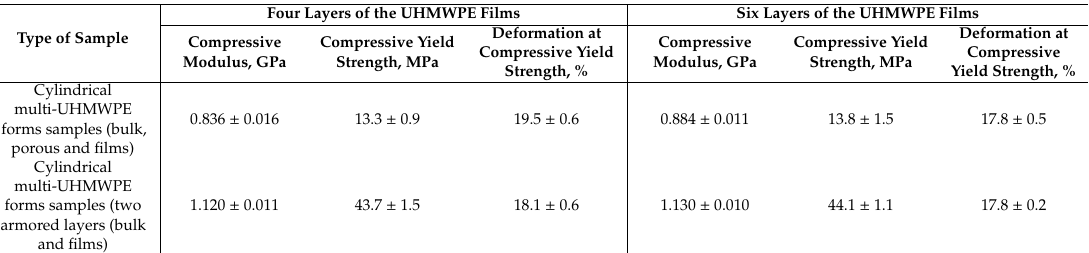
Table 5. Mechanical test results for the cylindrical multi- UHMWPE forms samples glued by thiol-ene glue with four and six layers of the UHMWPE films according to ASTM D-695. Four Layers of the UHMWPE Films Six Layers of the UHMWPE Films Deformation at Deformation at Compressive Compressive Yield Compressive Compressive Yield Compressive Yield Compressive Modulus, GPa Strength, MPa Modulus, GPa Strength, MPa Strength, % Yield Strength, % Cylindrical multi-UHMWPE forms samples (bulk, porous and